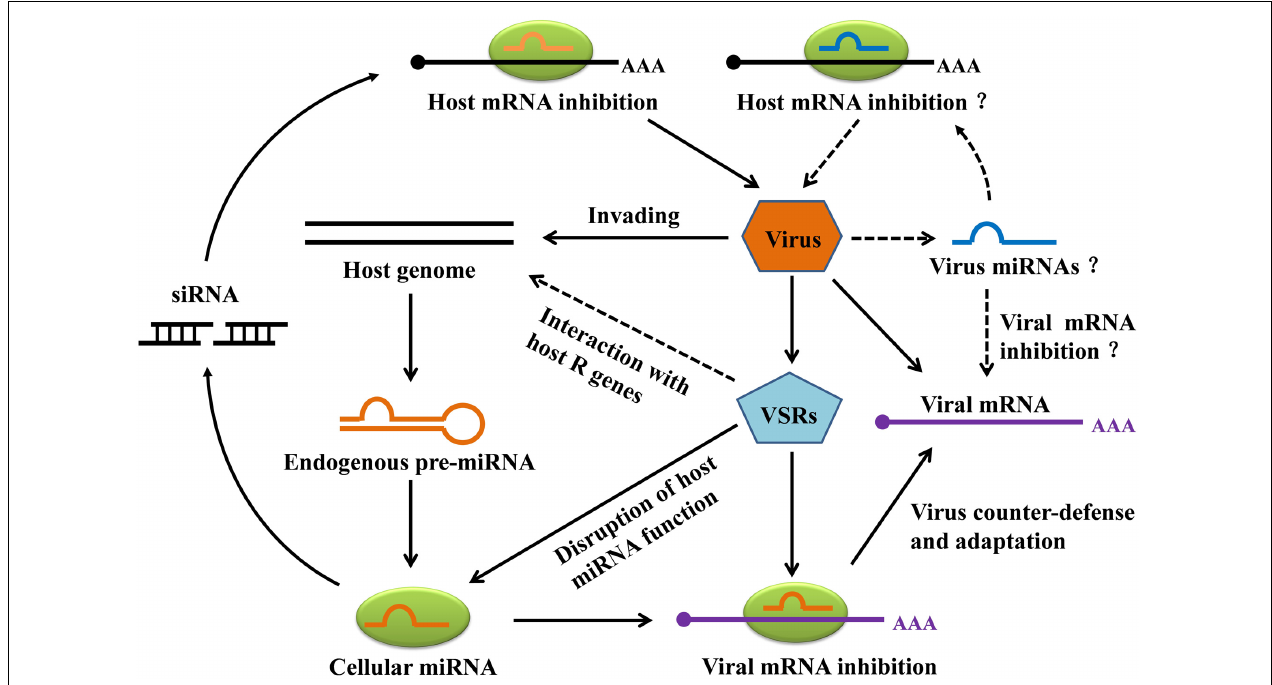
FIGURE 4 | Hypothetical model for miRNA-mediated gene silencing in plant-virus interaction. Invading viruses can trigger the production of plant endogenous miRNAs. In addition to specifically repressing the expression of host genes, the miRNAs can target viral mRNA for degradation. To counteract host miRNA-mediated gene silencing, viruses most notably express viral suppressors of RNA silencing (VSRs) to avoid host RNA silencing. VSRs can not only interfere with host miRNA function, but can also repress naturally occurring silencing of host R genes. Although plant virus-derived miRNAs have not yet been discovered, we illustrate hypothetical viral strategies, including miRNA-mediated repression of the host and viral transcripts.